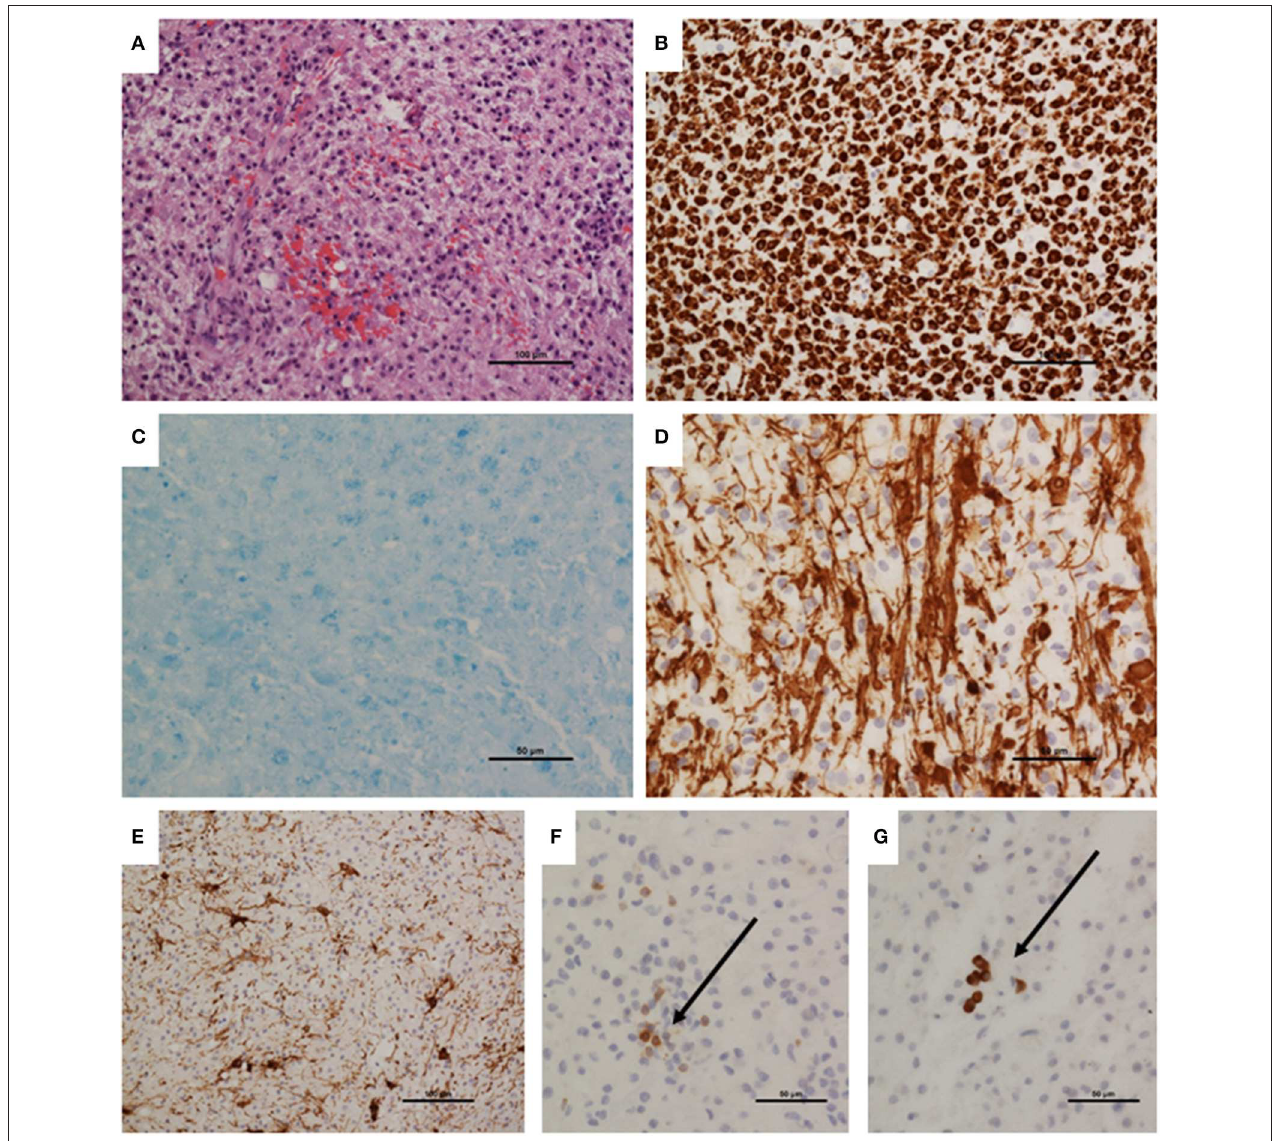
FIGURE 2 | Brain biopsy neuropathology. (A) Biopsy appeared hypercellular, with a dense macrophage infiltrate. (B) Infiltrating population was confirmed as macrophages by immunohistochemistry to CD68. (C) Luxol fast blue stain demonstrating virtually total myelin loss. (D) Immunohistochemistry demonstrated relative preservation of axons; these were separated by infiltrating macrophages, and show irregularity, representing damage. (E) Immunohistochemistry to GFAP showing reactive astrocytes. (F) Immunohistochemistry to CD3 demonstrated sparse T cells (arrow). (G) A few CD79a-positive B cells were also present. Magnifications as shown on scale